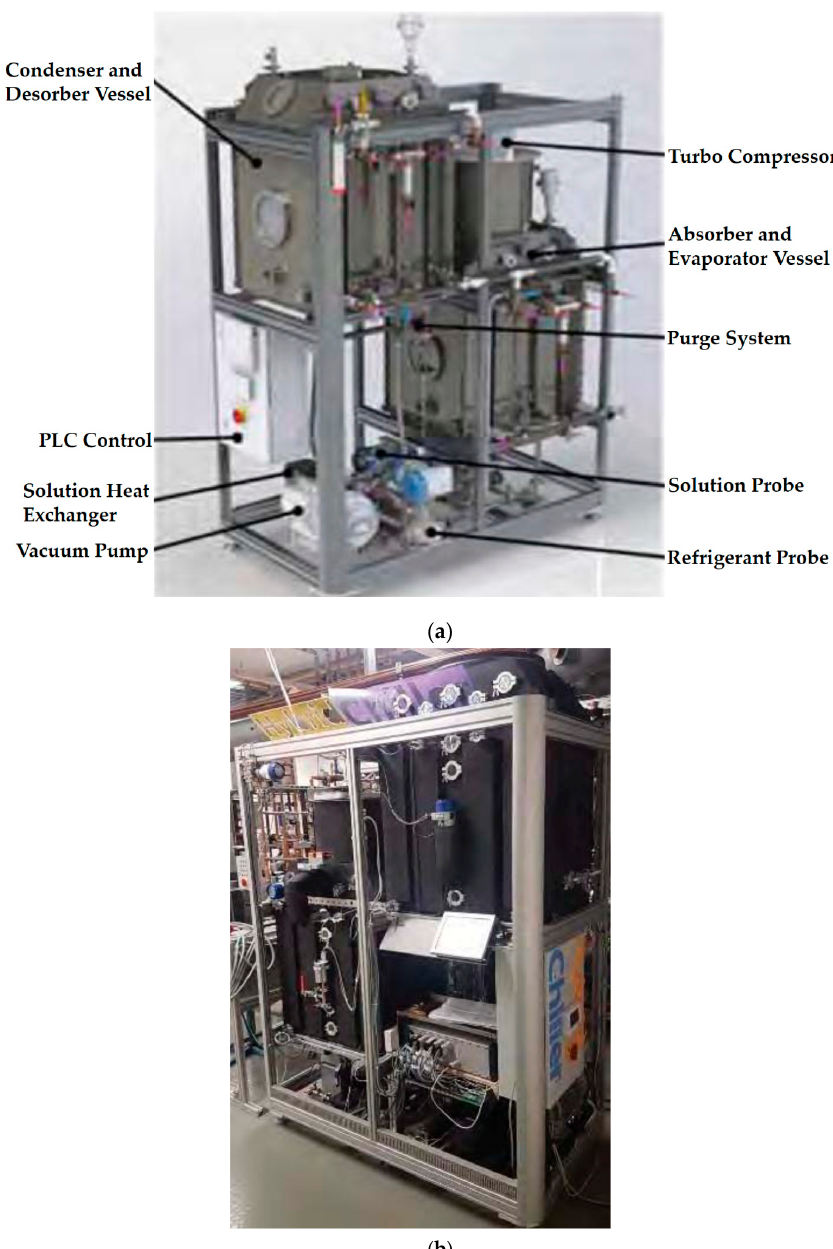
Figure 19. A prototype of the mechanical compressor-assisted single-stage water / LiBr absorption chiller developed at the Munich University of Applied Sciences (Germany). Adapted from Reference [82]. (a) Components of the prototype; (b) Internal view of prototype. Reproduced with the permission of the International Institute of Refrigeration (https://iifiir.org)+ Helm et al. [82].